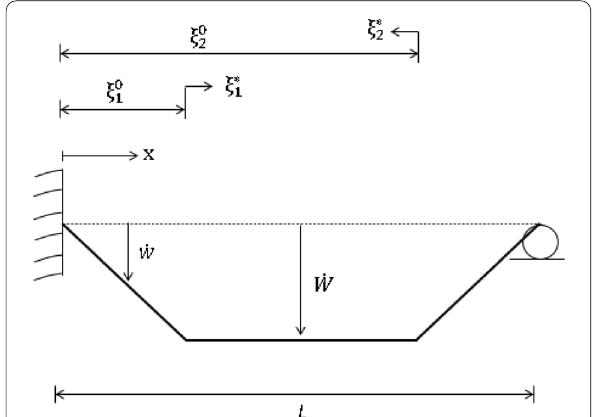
Fig. 11 Dynamic bending moment when the motion ceases ( P 0 = 2.5 P c ) .